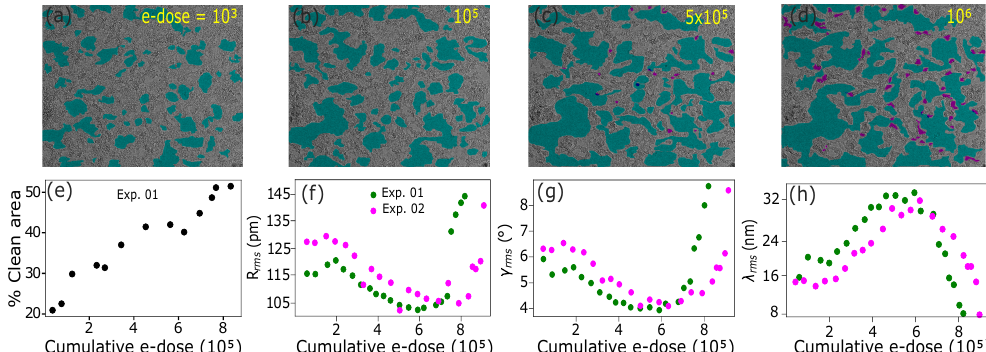
Figure 3. Influence of contamination and disorder on the corrugations. ( a – d ) TEM images of a graphene sample, recorded after a cumulative dose of 10 3 , 10 5 , 5 × 10 5 , and 10 6 e − /nm 2 , respectively. The cyan area corresponds to clean graphene. As the cumulative electron dose increases from 10 3 (image ( a )) to 10 5 e − /nm 2 (image ( b )), percentage of clean area also increases, whereas once the electron dose exceeds 5 × 10 5 e − /nm 2 , chemical etching becomes more prominent, as seen in the increase in violet areas that correspond to pores. Field of view is ca. 100 × 100 nm 2 . ( e ) Clean area as a function of the cumulative electron dose. ( f – h ) Measured roughness parameters from two different sample areas as a function of the cumulative electron